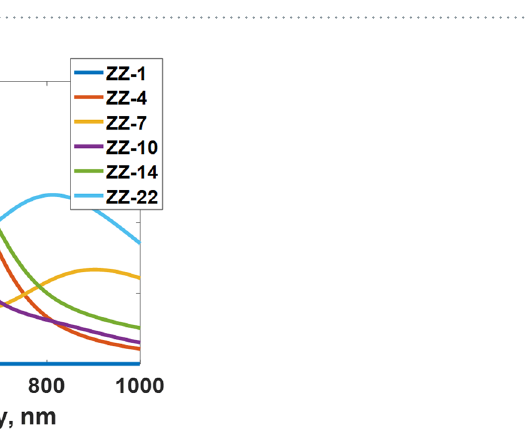
Figure 14. UV/Vis absorption spectra of the zigzag-edged and armchair-edged GQDs before and after complexation with divalent heavy metal ions, namely ( a ) Cd 2 + , ( b ) Hg 2 + and ( c ) Pb 2 + .